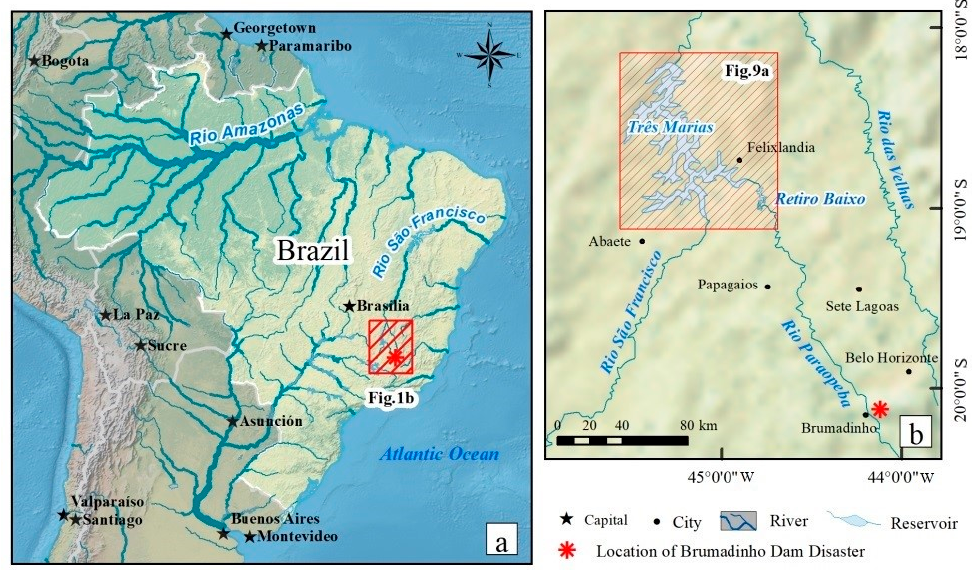
Figure 1. Location of Brumadinho dam disaster. (a) Location of the disaster in Brazil; (b) relative relationship between the disaster location and two reservoirs. Note that in Figure 1b, the position of two reservoirs were marked using a red box whose extent corresponds to Figure 9a.